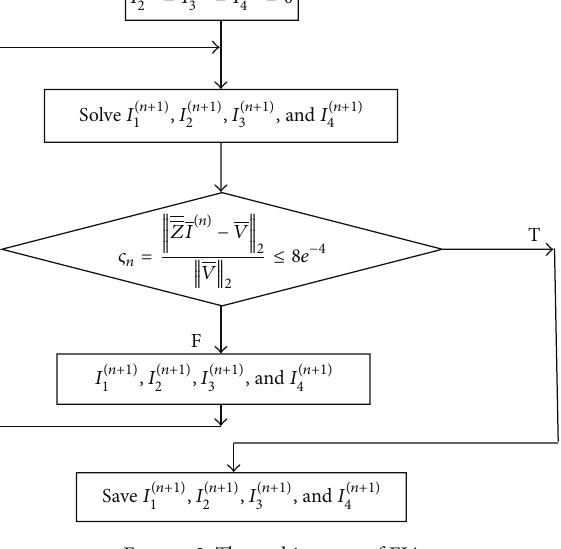
Figure 2: The architecture of FIA.